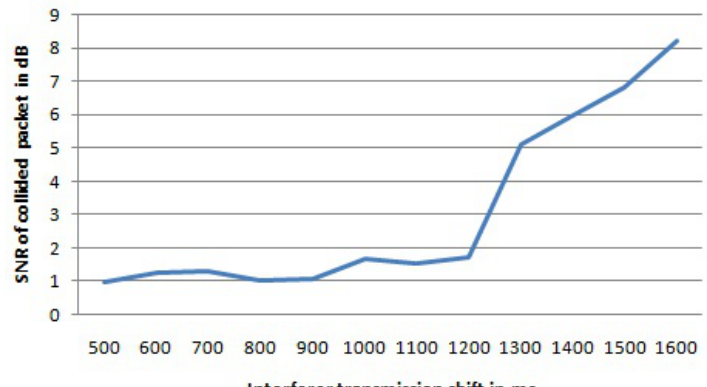
Figure 4. Average SNR value for received packets from the interfered transmitter for the first setting. For the first four shifts, there are no data since all the packets were